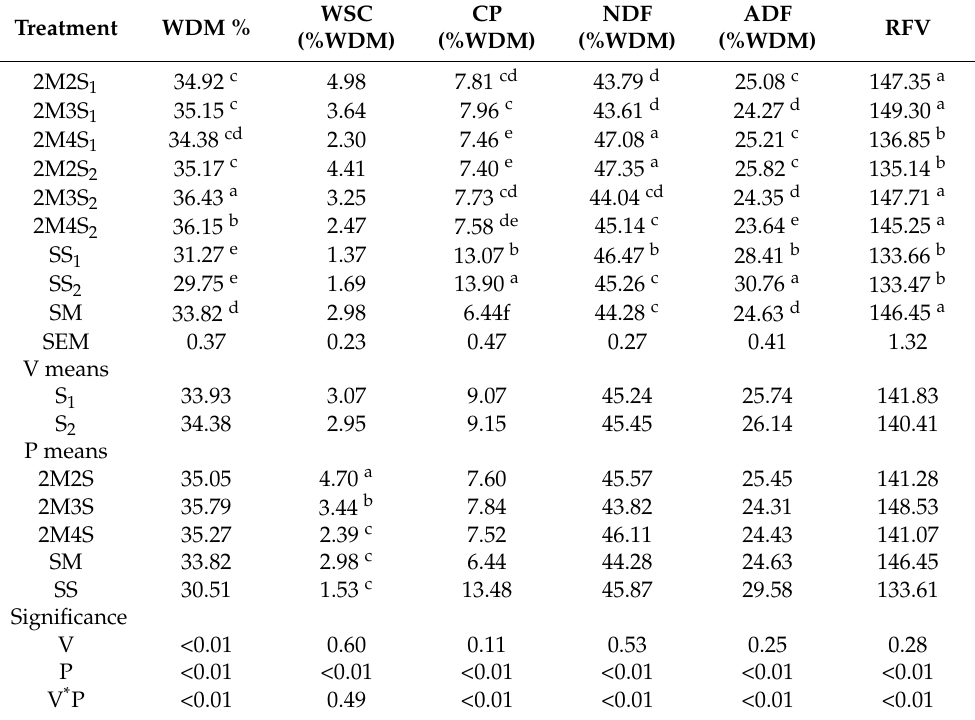
Table 5. Chemical composition of maize and soybean silage at 60 days of ensiling as affected by different planting patterns in